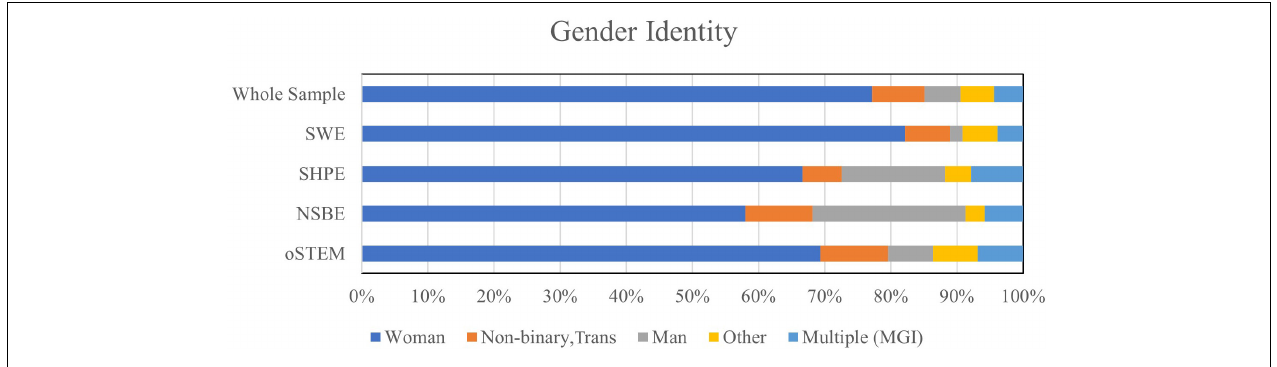
FIGURE 3 | Gender identity of sample, SWE, SHPE, NSBE, and oSTEM